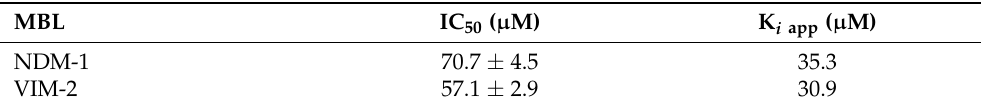
Table 2. Enzyme inhibition exhibition by BP2.